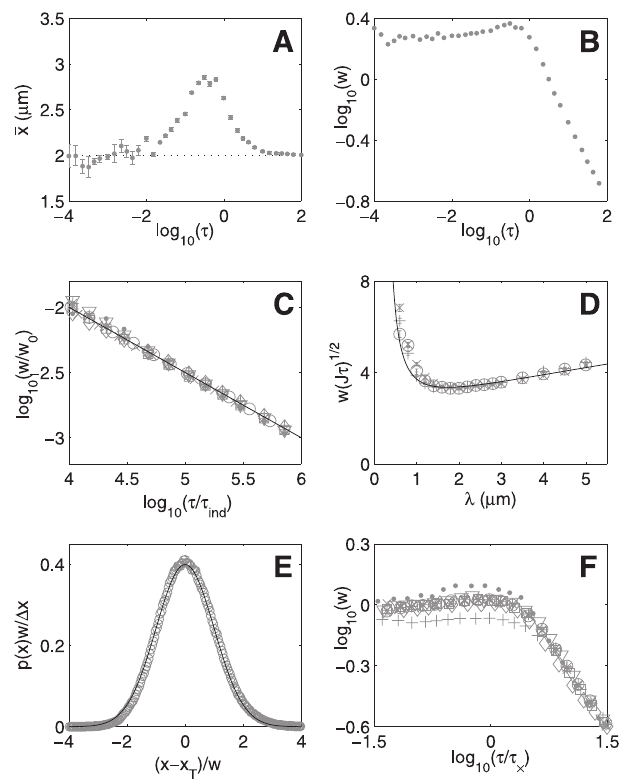
Figure 1. Single-Gradient Model in d ¼ 2 (A) Variation of the estimated threshold position with averaging time, with x T ¼ 2 l m and k ¼ 2 l m. (B) Variation of the width as a function of averaging time. (C) Data collapse of the width at large s for a range of parameter values. Full line shows the prediction of Equation 7 with k 2 d ¼ 0.40 and a ¼ 2.5. (D) w ( s ) as a function of decay length, with x T ¼ 2 l m. Results for three different averaging times are shown: 3 , s ¼ 10 s; circle, s ¼ 15 s; and þ , s ¼ 22.5 s. The full line shows the prediction from Equation 7. At large k , the simulation results deviate from the prediction since the assumption that L (cid:3) k is no longer valid. (E) Plot of the probability distribution for measuring the threshold at position x with an averaging time s ¼ 45 s. The full line shows a normal distribution. (F) Scaling of the crossover time, s 3 , according to Equation 13. In (A), (B), and (E), the standard parameter values given in the text were used. In (C) and (F), * indicates the standard parameter values. For the otherdatasets,oneparametervaluewaschangedasfollows:opencircle, D ¼ 0.5 l m 2 s (cid:2) 1 ; open square, J ¼ 6.25 l m (cid:2) 1 s (cid:2) 1 ; 3 , D x ¼ 0.02 l m; closed circle, l ¼ 1 s (cid:2) 1 ; þ , l ¼ 0.11 s (cid:2) 1 ; opendiamond, x T ¼ 1 l m; and invertedtriangle, x